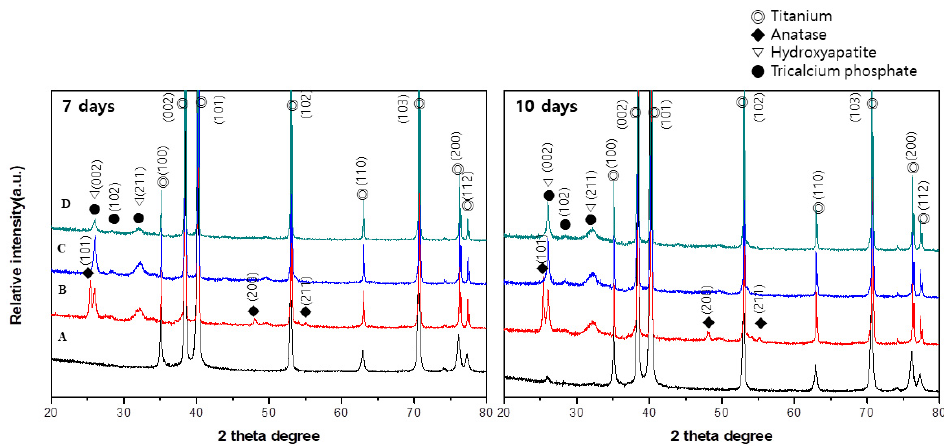
Figure 5. XRD patterns of difference specimens after immersion in SBF for 7 and 10 days: (A) PT; (B) PTN; (C) PTNA; and (D) PTNAC.